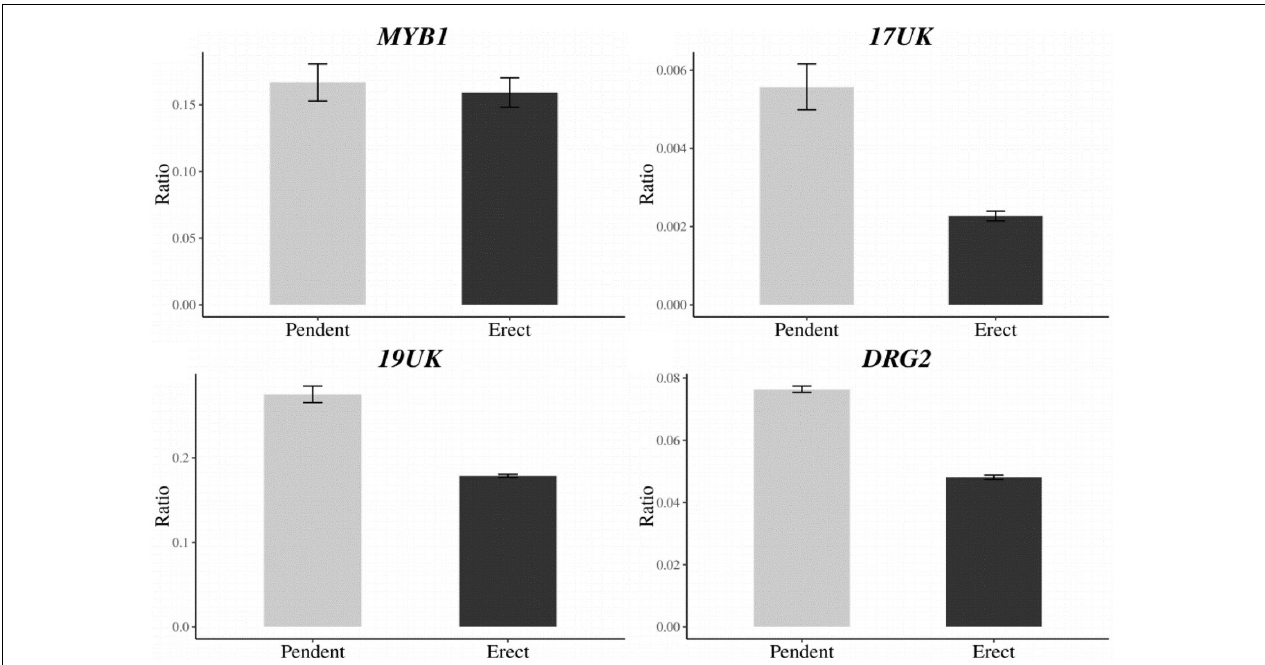
FIGURE 5 | Expression levels of the CapUp candidate genes ( MYB1 , 17UK , 19UK , and DRG2 ) in UG population. The y -axis shows the expression level relative to that of the housekeeping gene Actin . The x-axis shows phenotype. The bars indicate the range of standard error of the mean.